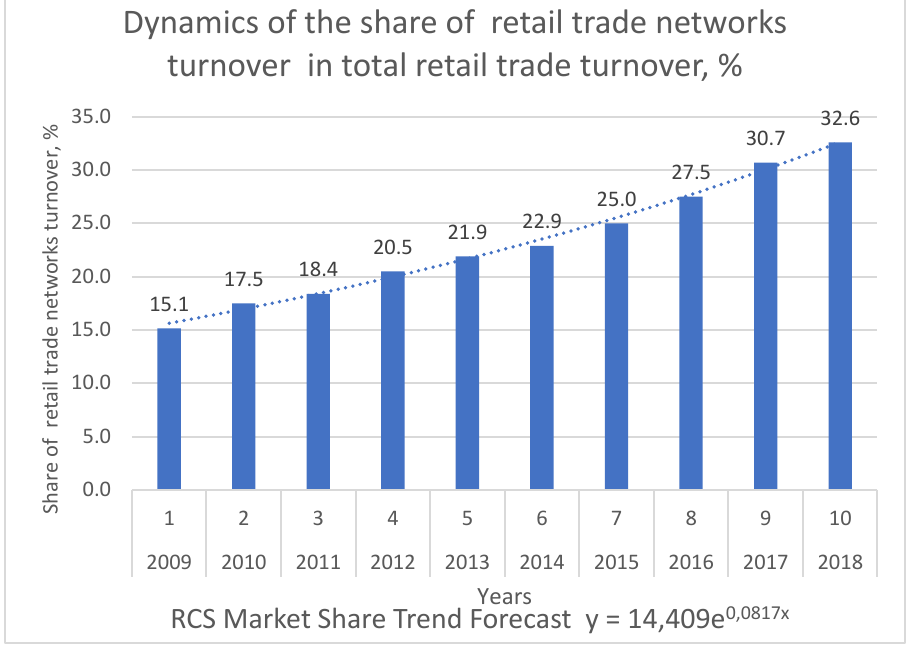
Figure 2. Dynamics of the share of retail trade networks turnover.